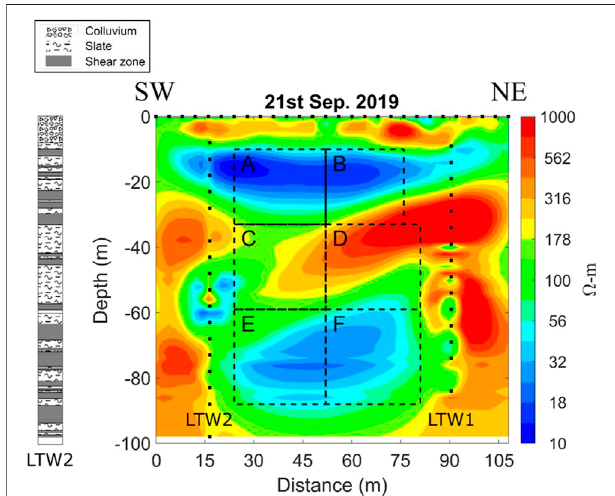
FIGURE 6 | Cross-section of the electrical resistivity image and its subzones.TheERTimagewasdividedintosixsubzonesA-F,accordingtothe depths and the resistivity values, for discussing in the text the details of the resistivity and RWS variations caused by rainfall events. For the depths, Zones A and B are shallower than 30 m; Zones C and D from 30 to60 m; and Zones Eand F deeper than 60 m. Thelower resistivityvalueswithseveraltens of ohm-meters appear in Zones A, B, E, and F while Zones C and D have the higher resistivity values with several hundreds of ohm-meters. The lithology column was also carefully registered from the drill core at the borehole of LTW2 (modi fi ed from Lin M. L. et al., 2017). Comparison with the lithology columnofLTW2suggeststhattheresistiveZonesCandDmaybeassociated with those more intact slate formations in the depths between 30 and 60